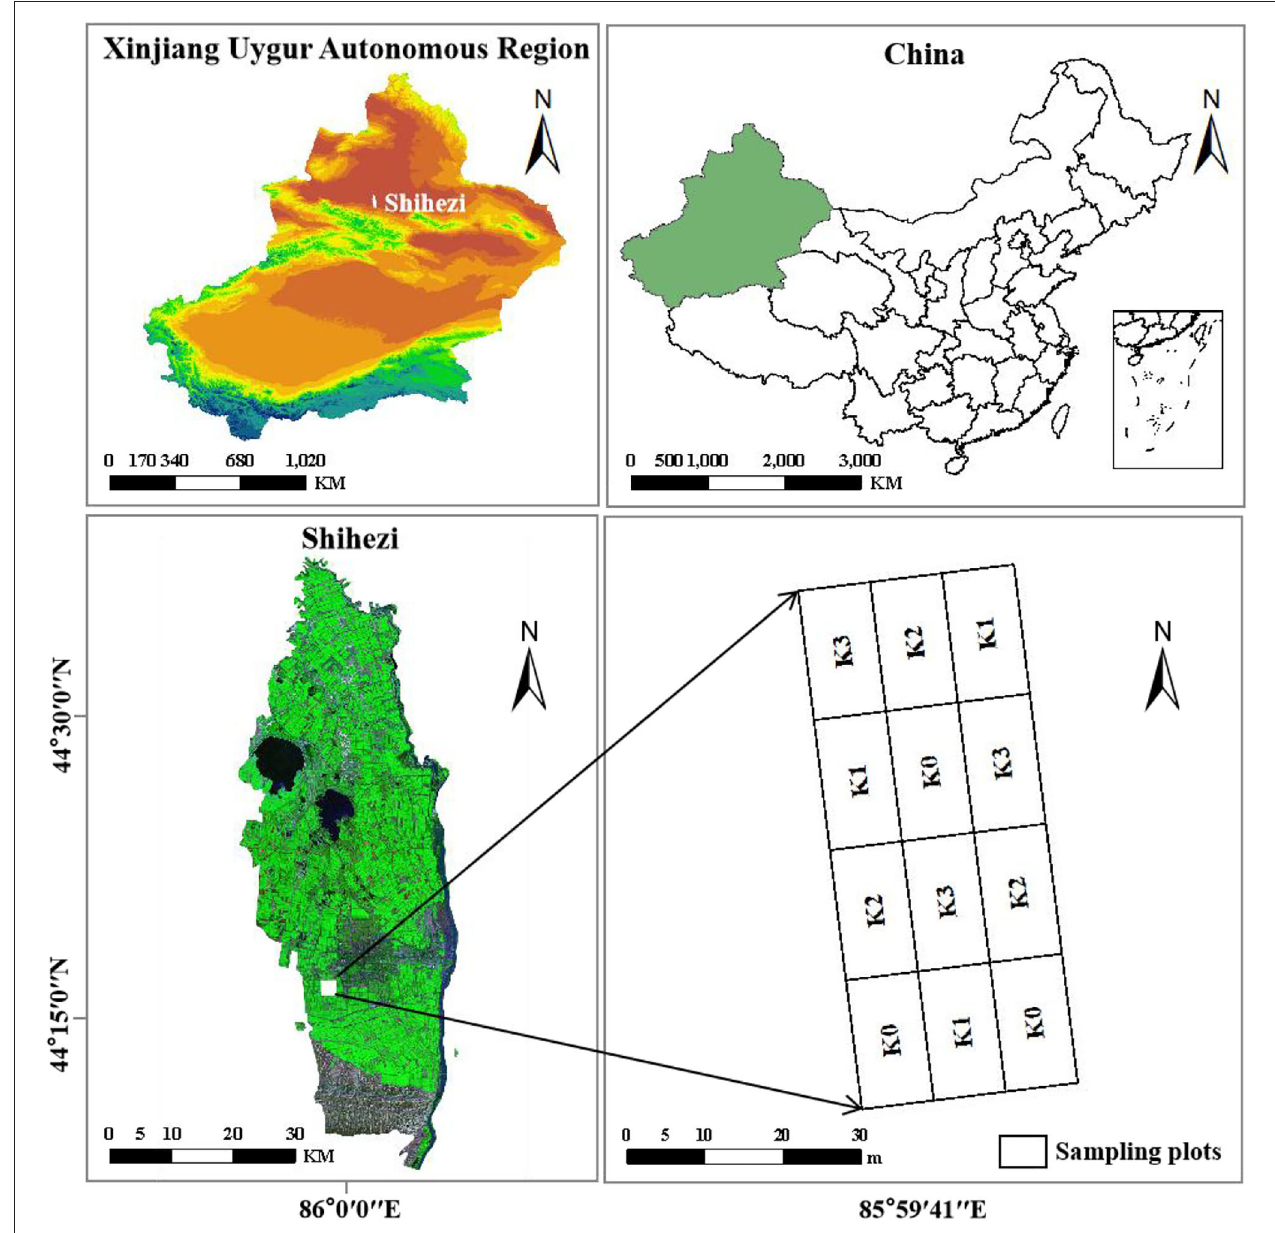
FIGURE 1 | The study site and the location of the